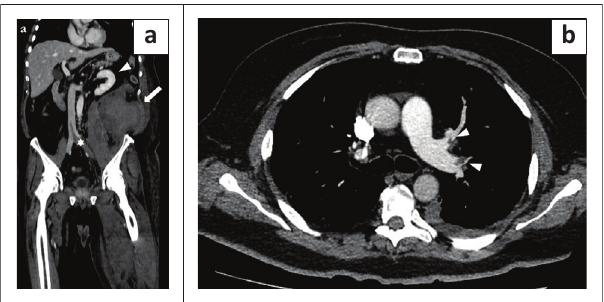
FIGURE 6: A 59-year-old man with a left retroperitoneal haematoma diagnosed 19 days after hospital admission. (a) Coronal plane, venous phase image shows a retroperitoneal haematoma (arrow) and an extensive thrombus in the left iliac vein extending into the inferior vena cava (asterisk). The left kidney is displaced by the haematoma (arrowhead). (b) Axial plane, pulmonary arterial phase demonstrates pulmonary thrombo-embolism (arrowheads). The patient underwent endovascular embolisation and survived.